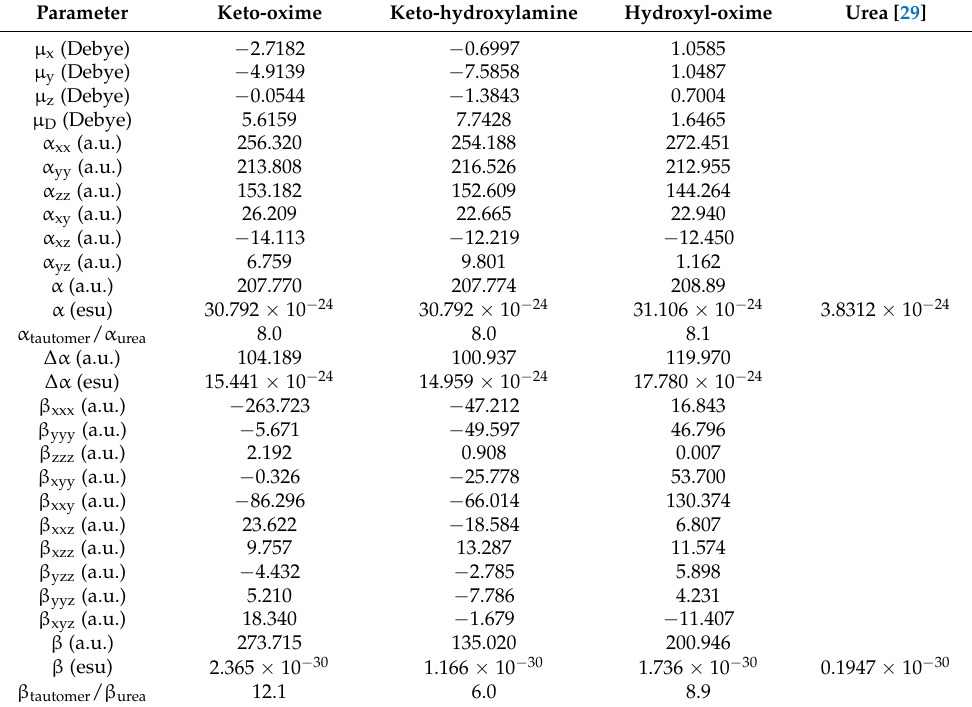
Table 8. Nonlinear optical parameters for the ground state of the optimized structure of the keto- oxime, keto-hydroxylamine and hydroxyl-oxime tautomers of molnupiravir, and urea [29], obtained by using the DFT/B3LYP/6-311++G(d,p) method 1 .